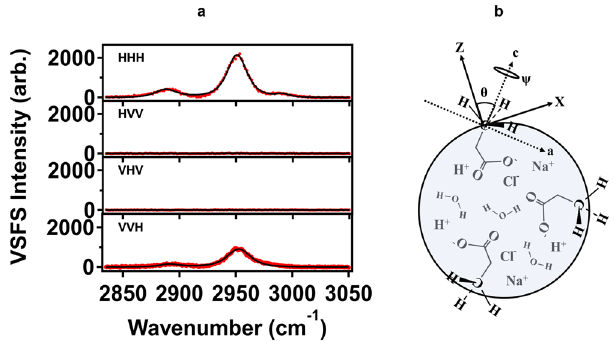
Fig. 3 Vibrational sum frequency scattering (VSFS) spectra of aerosol particles with different polarizations. a Polarized VSFS spectra for aerosol particles from 4 M propionic acid in a 0.5 M NaCl seed solution with HHH, HHV, HVH, and VVH (H horizontal polarization, V vertical polarization). b Schematic of orientational con fi guration of the – CH 3 group of propanoic acids at the aerosol